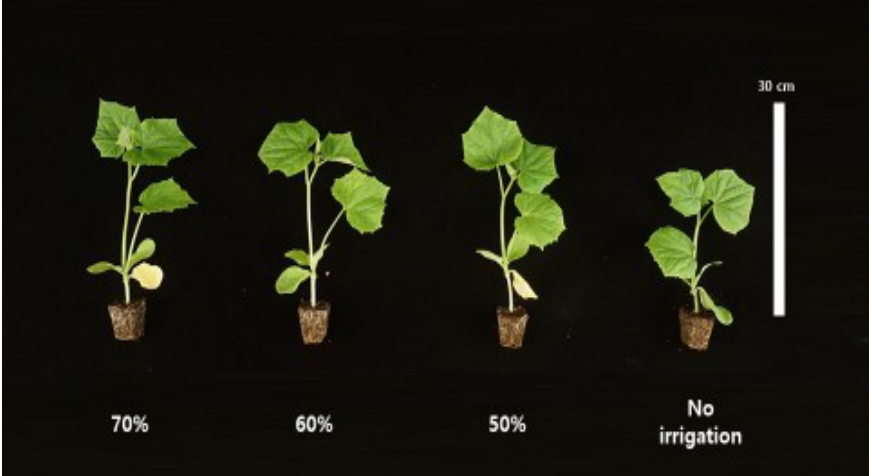
Figure 5. Grafted cucumber seedlings as affected by different irrigation regimens during the cultivation of scions and rootstocks in a PFAL.